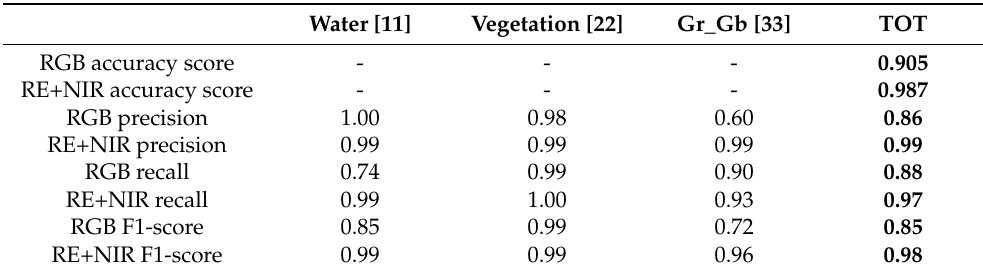
Table 4. Second classified cloud accuracy parameters